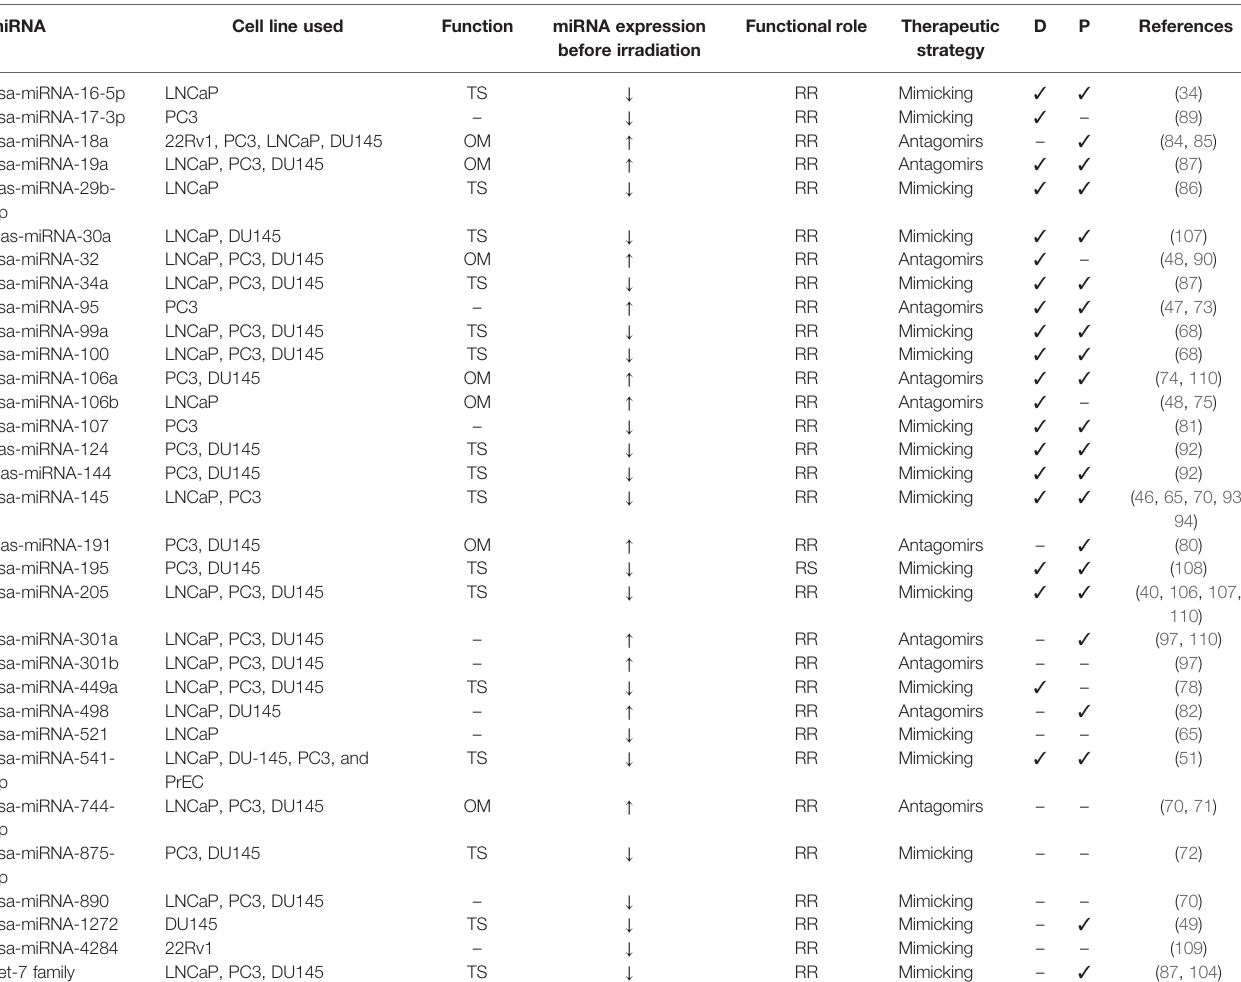
TABLE 1 | MiRNA expression in radiation response in prostate cancer cell lines. miRNA Cell line used Function miRNA expression